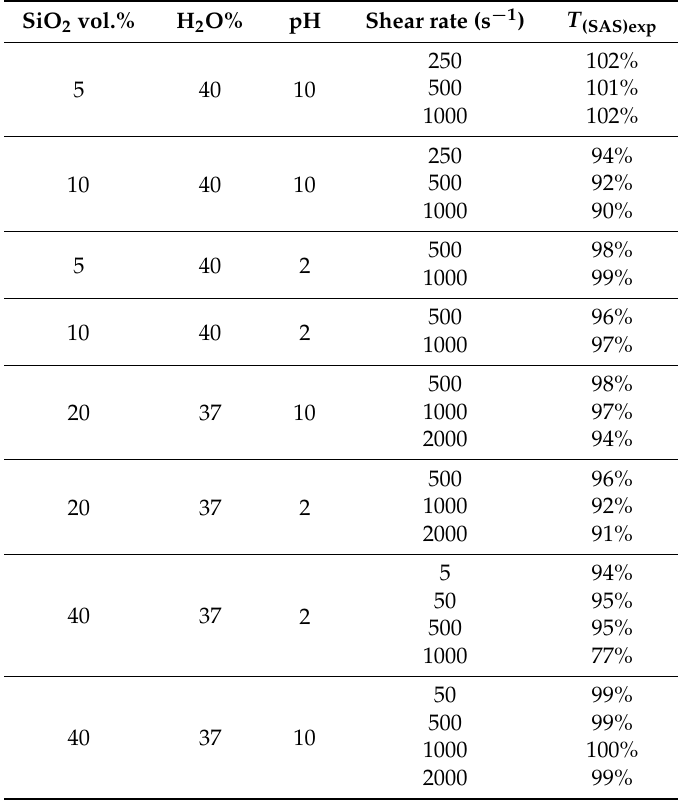
Table 2. T SAS values experimentally determined from rheo-USANS measurements. The error in experimental T SAS values is estimated to be about